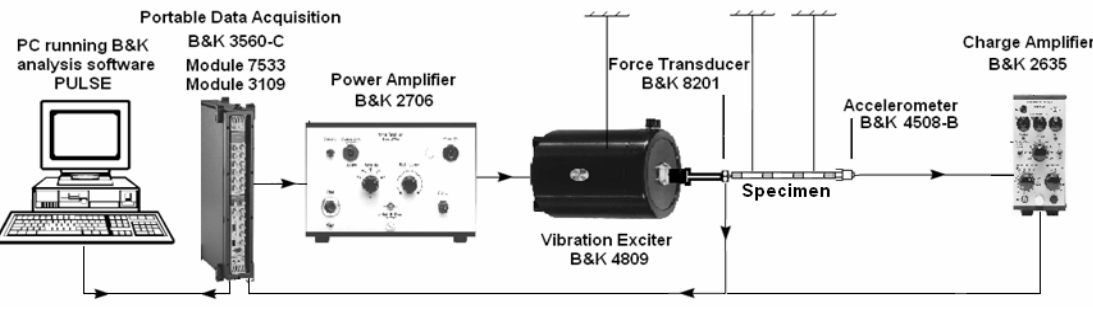
Fig. 3. Scheme illustrating the experimental